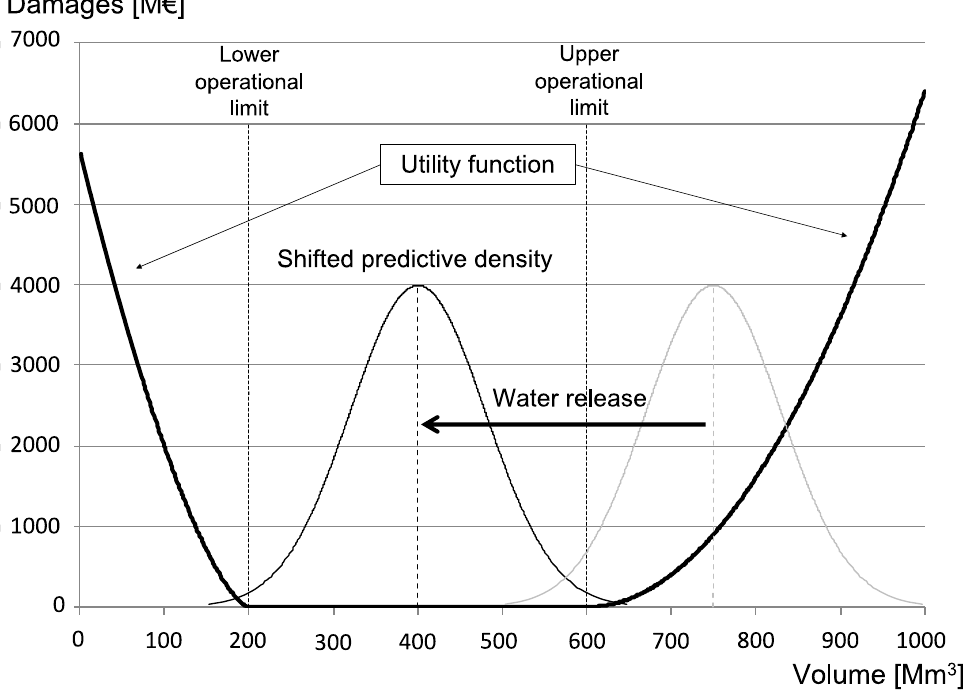
Figure 10. A simplified example of how a probabilistic forecast (thin black bell-shaped predictive density) can be used to derive appropriate decisions for reservoir releases. For a given probabilistic prediction (grey bell-shaped solid line), the expected loss, namely, the integral of the product of the density times the utility function of Equation (1) (solid thick black curve), is rather large. By releasing water, thus, reducing the volume in the reservoir, the probabilistic forecast of the cumulated volume is shifted downwards and is represented by the solid line bell shaped curve. As can be noticed, the expected utility value now becomes negligible. The appropriate amount to be released will then be found by comparing the expected utility function value to the cost of lack of future water availability (redrawn from [2]).